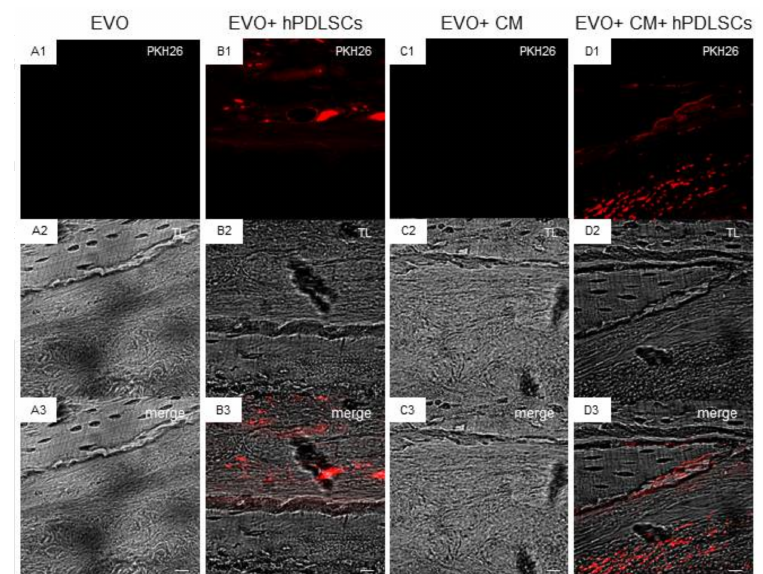
Figure 4. Confocal laser scanning microscope analyses. 3D reconstruction of ( A1 – A3 ) EVO, ( B1 – B3 ) EVO + hPDLSCs, ( C1 – C3 ) EVO + CM, ( D1 – D3 ) EVO + CM + hPDLSCs. hPDLSCs were stained with PKH26-Red Fluorescent Cell Linker Kit (PKH26, Sigma-Aldrich, Milan, Italy) (red), EVO was observed through transmission light channel (gray). Scale bars = 100 µ m. Mag = 40 × .